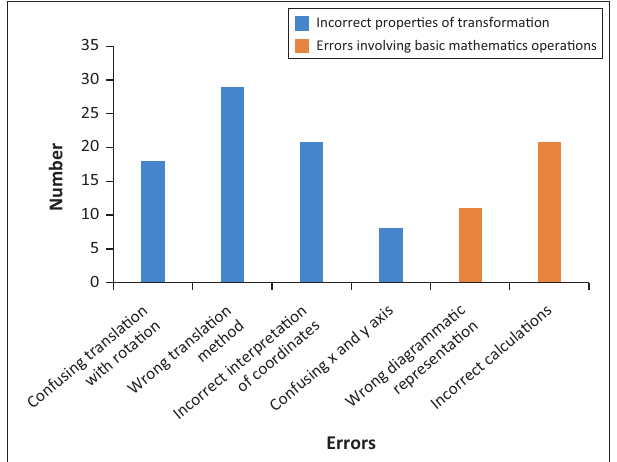
FIGURE 1: Prominent student errors according to